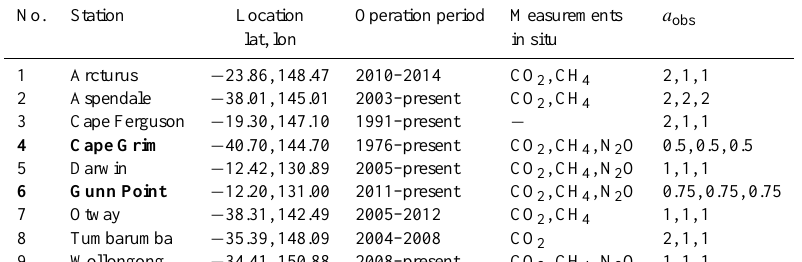
Table 1. Location of existing greenhouse gas measurement stations in Australia. Stations that are currently operational and have been selected for the base network are highlighted in bold typeface. The factor a obs is used to scale the observational uncertainties for CO 2 , CH 4 and N 2 O in a sensitivity experiment. For Cape Grim and Gunn Point a obs is used in all experiments.